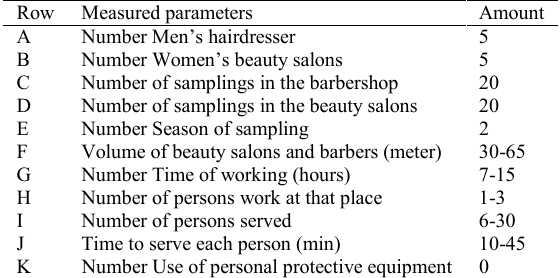
Table 1. The frequency of measuring the effective